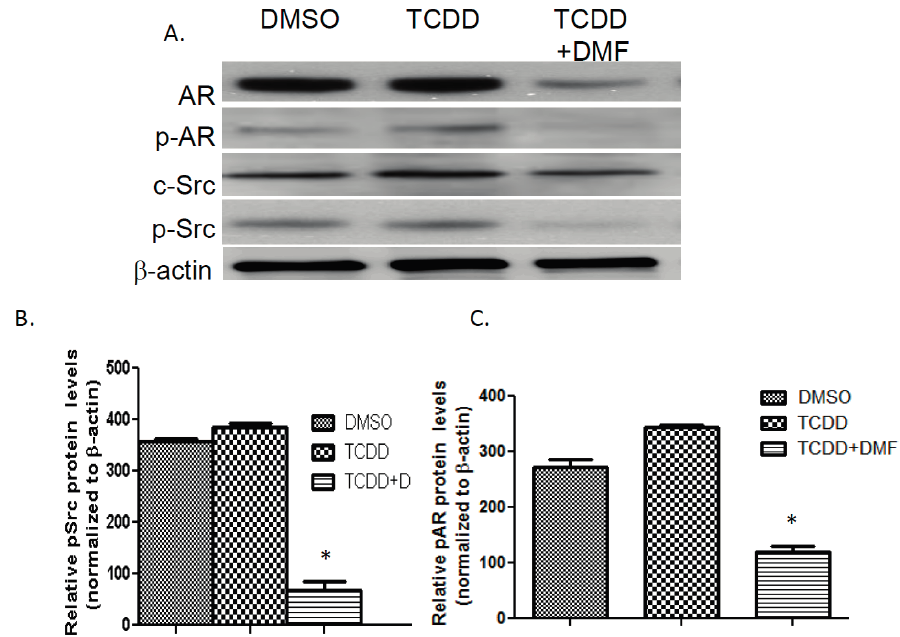
Figure 4. Western blot analysis of Src and AR phosphorylation. LNCaP cells were treated with DMSO, 1 μ M TCDD or 10 μ M DMF for 24 h. Total protein transferred to PVDF membrane was probed with AR, pAR, Src and pSrc antibodies ( A ). Bottom left panel is representative of pSrc protein expression ( B ) and bottom right panel of pAR protein expression ( C ). Image J was used to obtain densitometric measures from three independent membranes. Each bar represents mean +